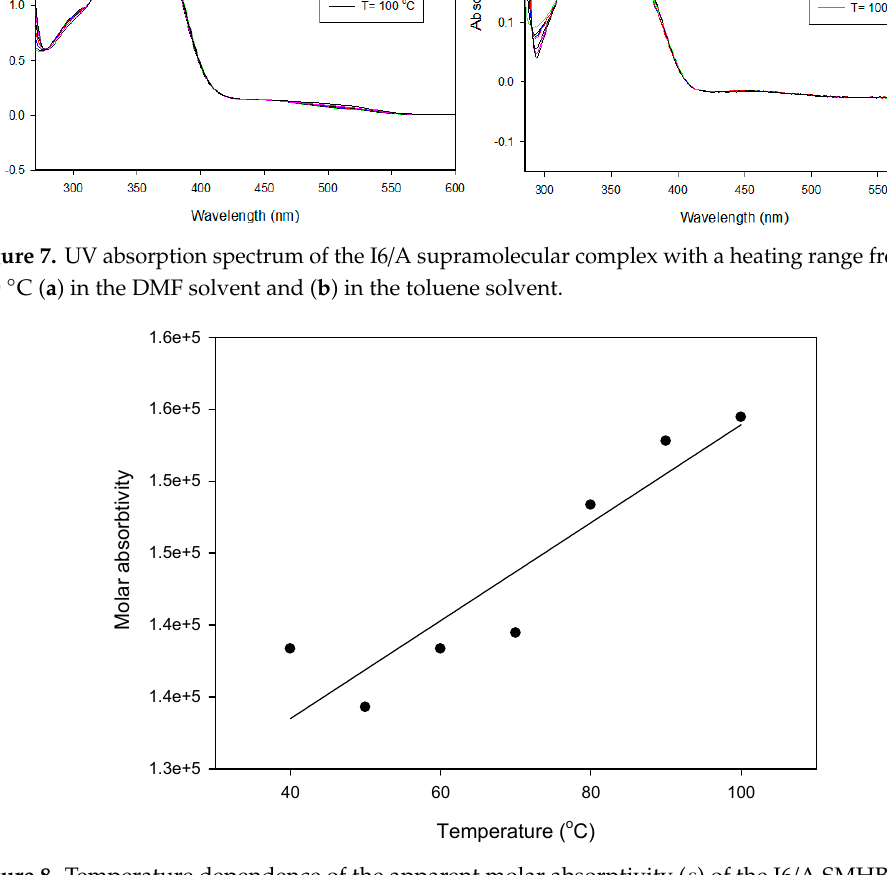
Figure 8. Temperature dependence of the apparent molar absorptivity ( Ɛ ) of the I6/A SMHBC in the toluene solvent.